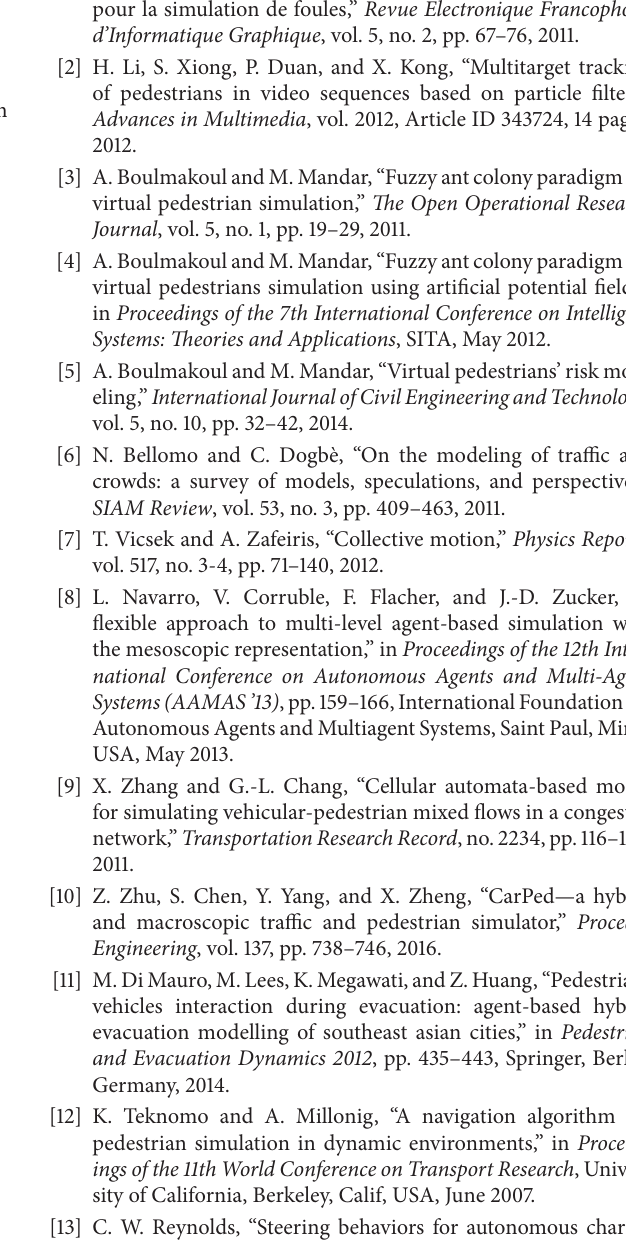
Figure 15: Fundamental diagram in a